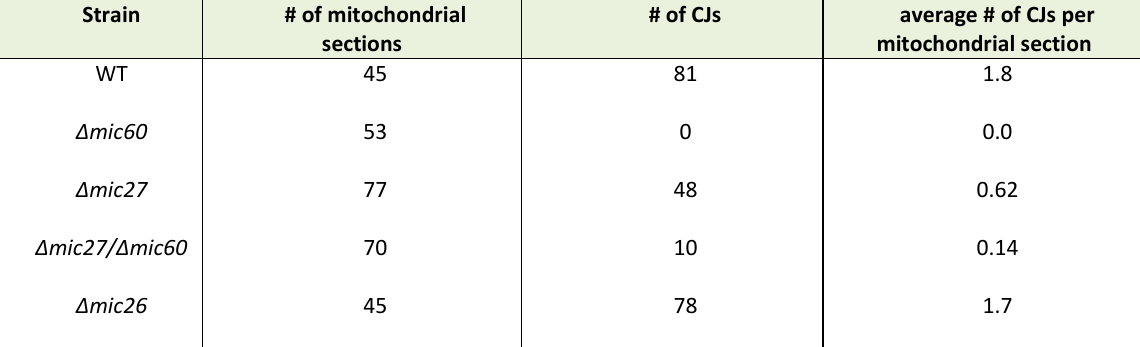
Indicated strains were grown on non-fermentative growth medium at 30°C, chemically fixed and analyzed by transmission electron micros- copy. The number of CJs per mitochondrial section was quantified. The Δ mic26 /Δ mic60 was not growing under these growth conditions (see Fig. 1A) and thus could not be